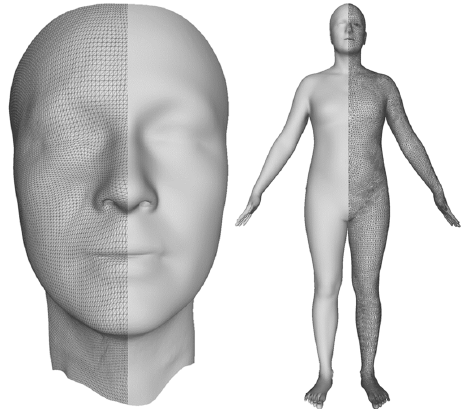
Figure 1. Templates. The average face template is on the left, and the average full-body template is on the right. The face has a regular (triangular) mesh grid as opposed to the less structured, but still simple, full-body mesh. The figure, for visualization purposes, shows templates with half-rendered surfaces and half as meshes.